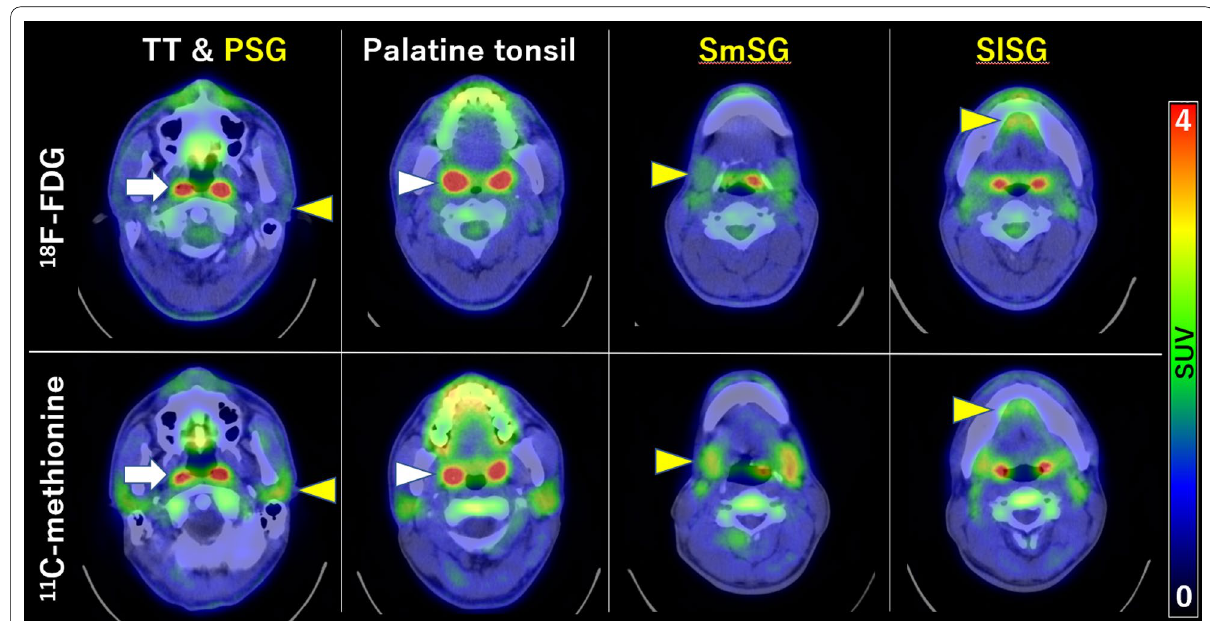
Fig. 3 Representative PET/CT images of a 37-year-old male patient. Upper row, [ 18 F]FDG PET/CT images; lower row, [ 11 C]methionine PET/CT images. TT (tori tubarius, white arrows), Palatine tonsil (white arrowhead), PSG (parotid salivary gland, yellow arrowheads), SmSG, (submandibular salivary gland, yellow arrowheads), and SlSG (sublingual salivary gland, yellow